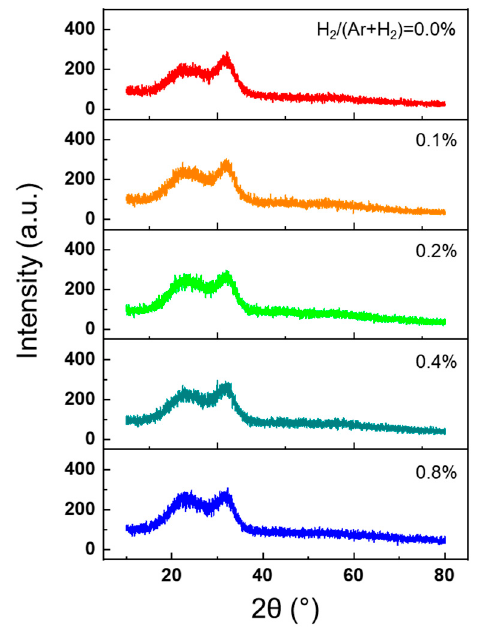
Figure 1. XRD patterns of In − Zn − O thin films deposited with various hydrogen flow Figure 1. XRD pa tt erns of In − Zn − O thin fi lms deposited with various hydrogen fl ow rates.